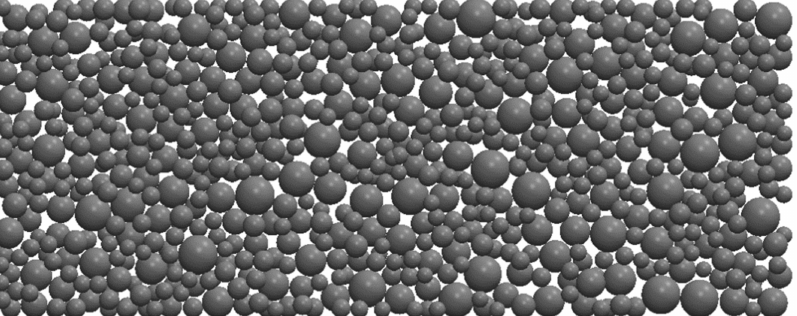
Figure 8. 316L stainless steel single-layer powder layer